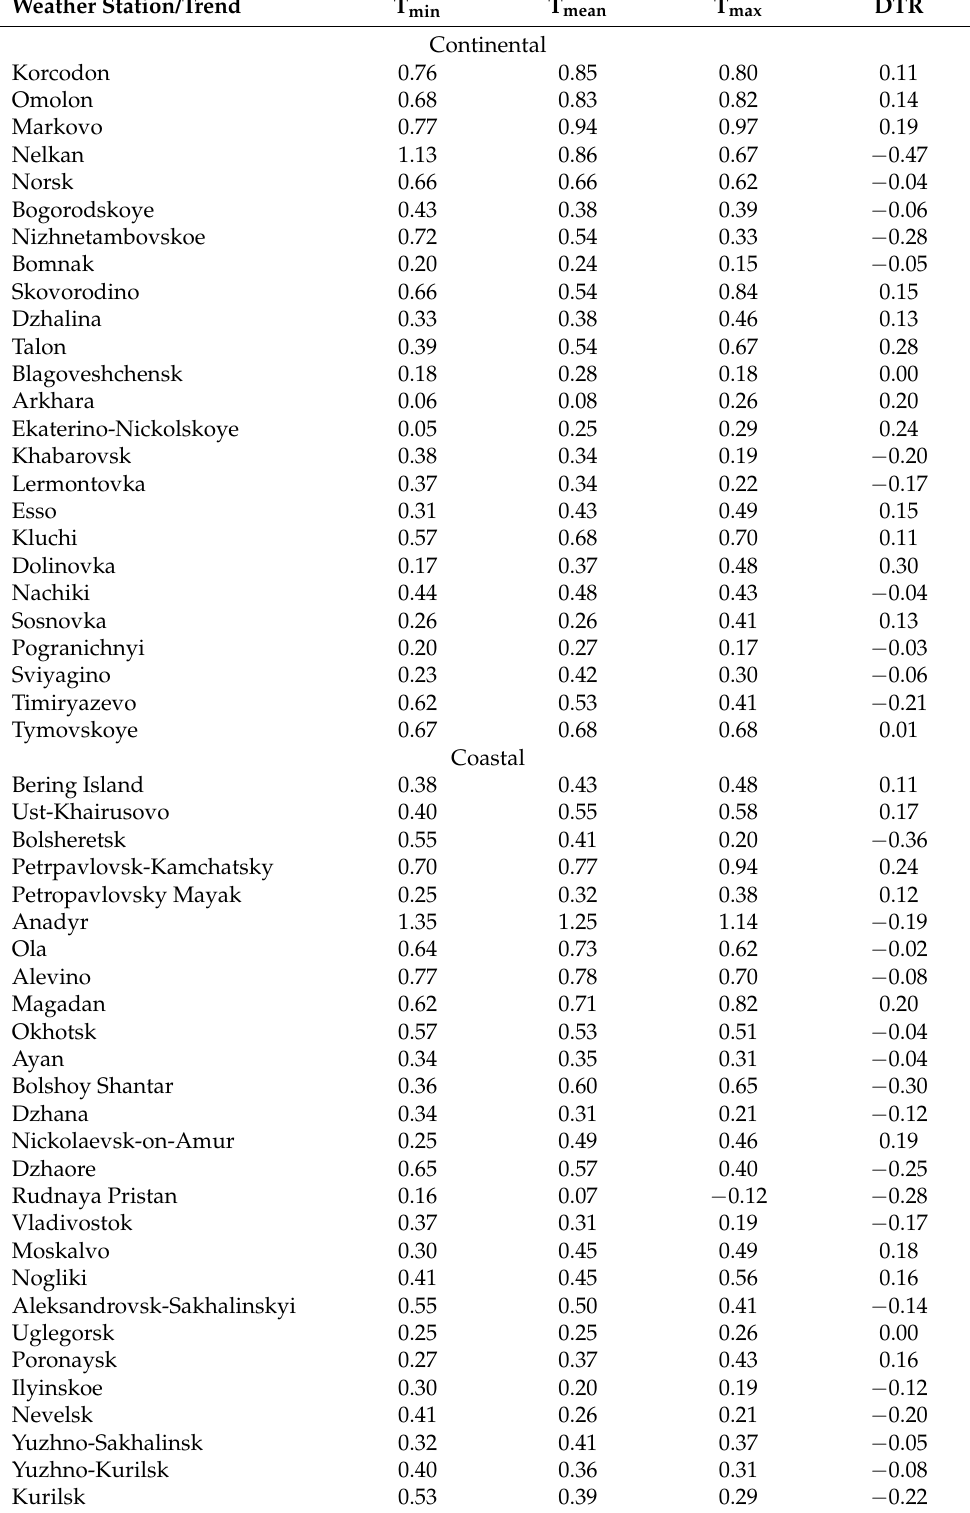
Table 2. Temporal trends ( ◦ C per 10 years) of daily temperatures for some continental and coastal locations at the Russian Far East, where trends are significant according to the Mann–Kendall test at the 0.05 level,